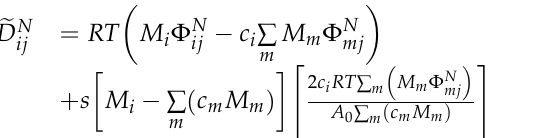
Figure 4. Comparison between the experimental and the simulated concentration profiles/interdiffusion fluxes of diffusion couples annealed at 1373 K for 46 h as well as the evaluated diagonal interdiffusivities. Symbols are due to the experimental measurements.